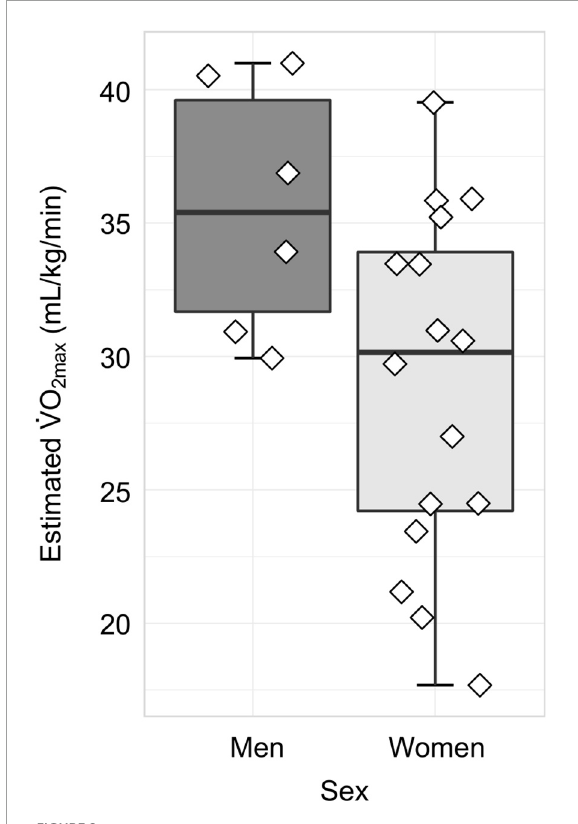
FIGURE2 Distribution of cardiorespiratory fitness, as measured by estimated ˙VO 2max , separated by sex. In women ( N = 16), the mean ± SD estimated ˙VO 2max was 28.95 ± 6.50 mL/kg/min, whereas in men ( N = 6), the mean ± SD estimated ˙VO 2max was 35.53 ± 4.72